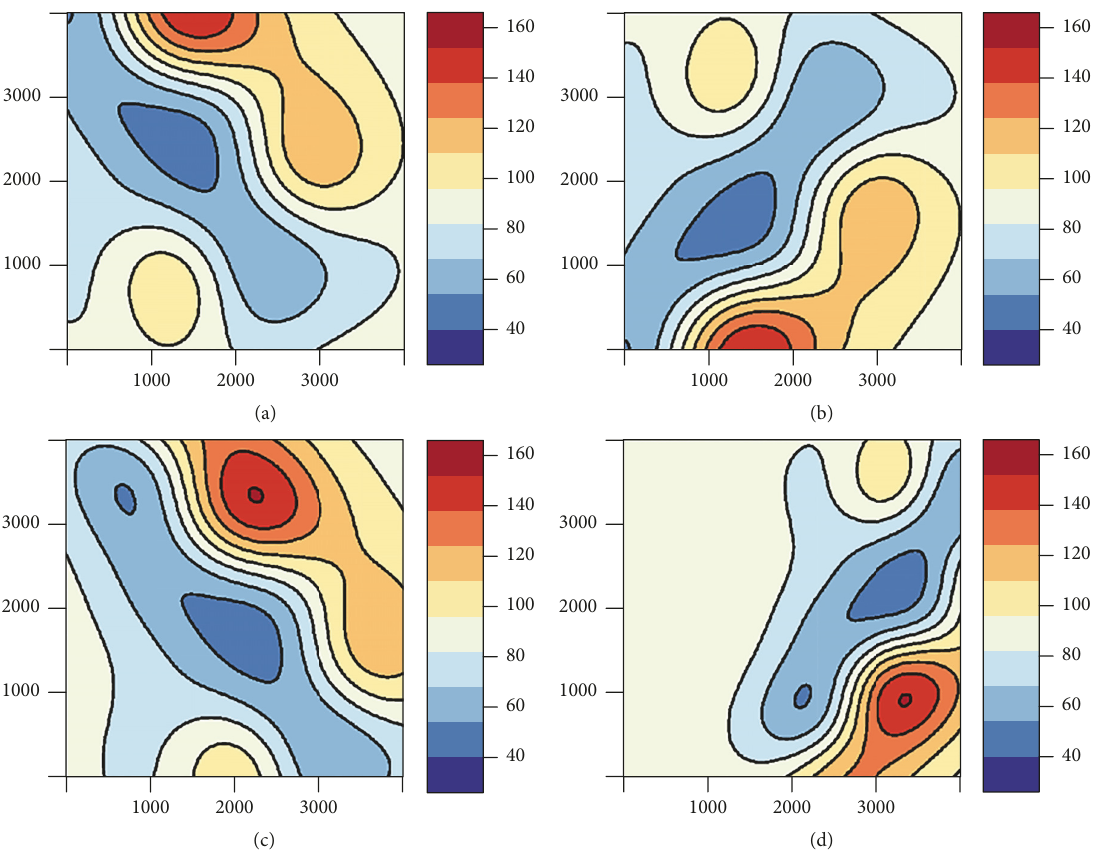
Figure 9: Pollution distribution examples used for validation.